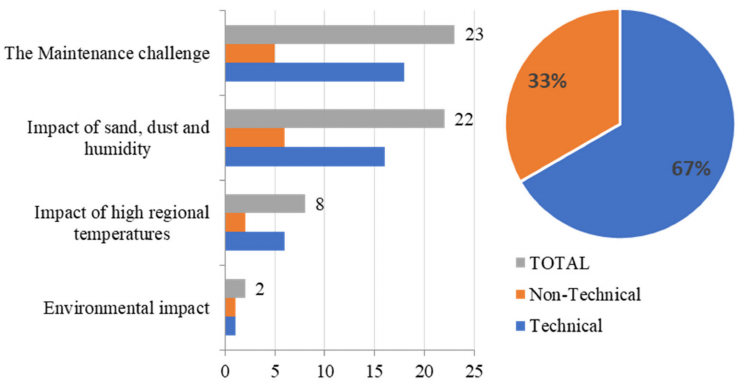
Figure 7. Environmental barrier sub-themes with the number of participants who